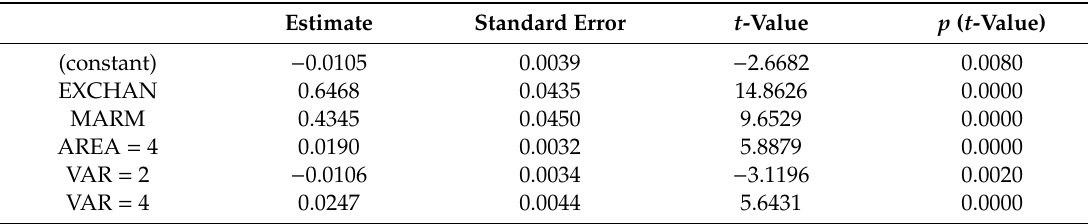
Table A6. Regression coe ffi cients for the model of the field prices of oranges without considering the time (MONTH)